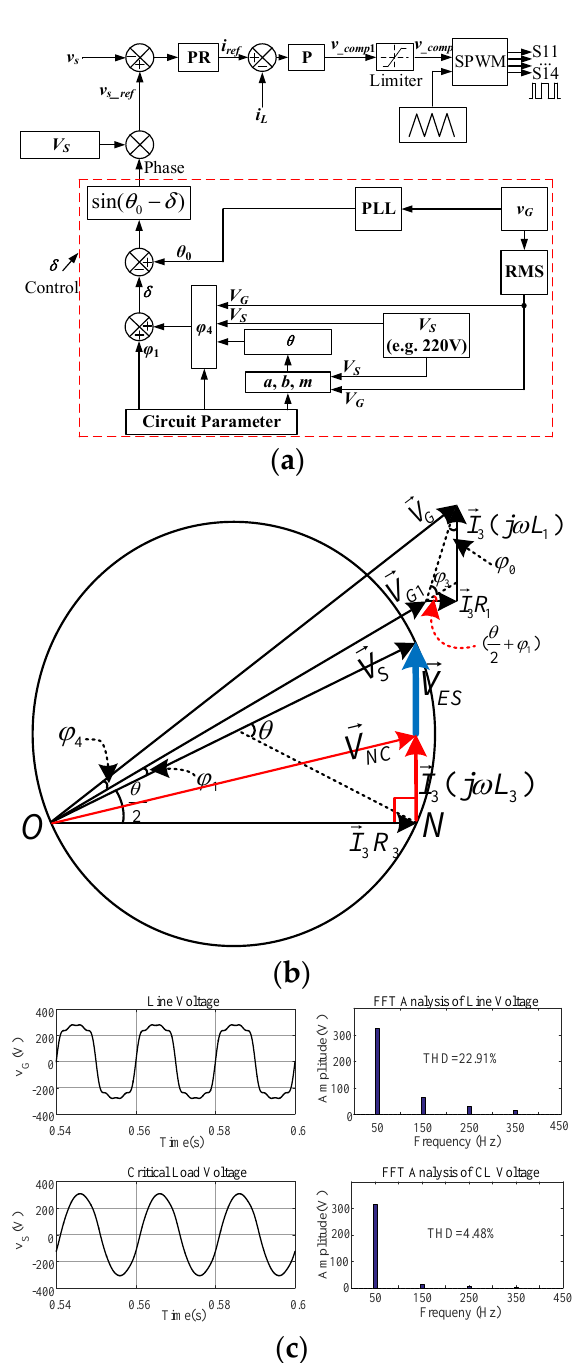
Figure 2. Existing control strategy. ( a ) Control diagram referenced from [5], ( b ) Vector diagram of δ control setting inductive mode, ( c ) Total harmonic distortion analysis of line voltage and CL voltage under distorted conditions.